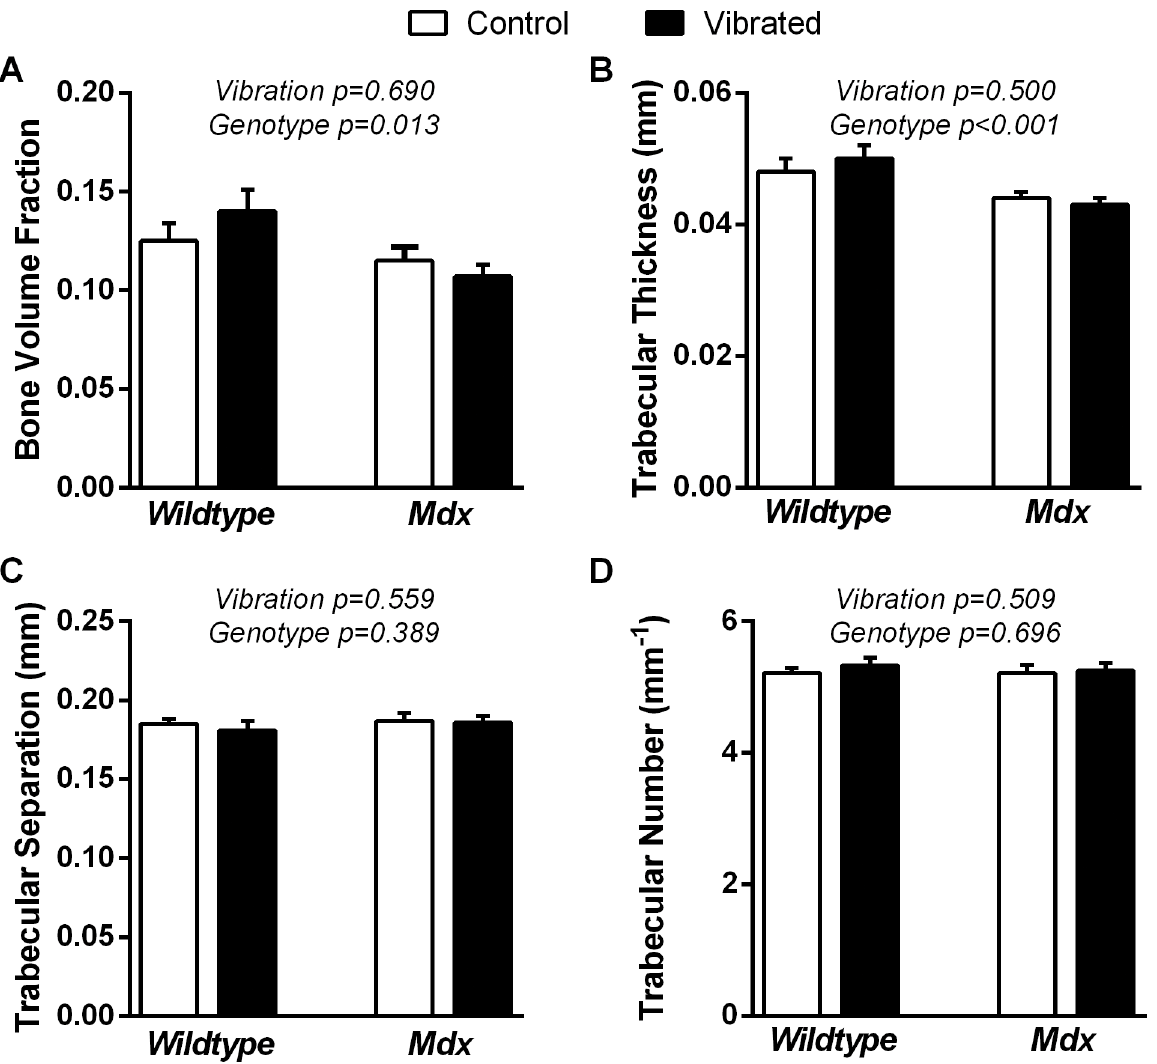
Figure 4. Eight weeks of vibration training did not impact trabecular bone in the tibia. Vibration training for 8 weeks did not influence trabecular bone A) volume fraction, B) thickness, C) separation, or D) number. As expected, mdx mice had lower values for trabecular bone volume fraction and thickness compared to wildtype mice. Data are means 6 SE. P-values associated with the main effects of two-way ANOVAs are indicated above each set of bars. Interactions between vibration and genotype was P $